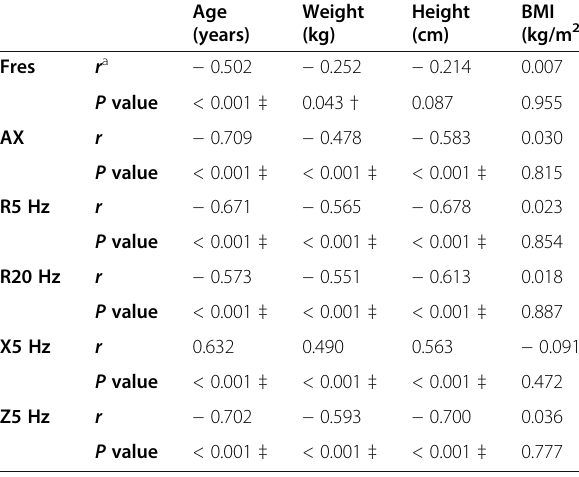
Table 3 Correlation between IOS parameters and both age and anthropometric measures among